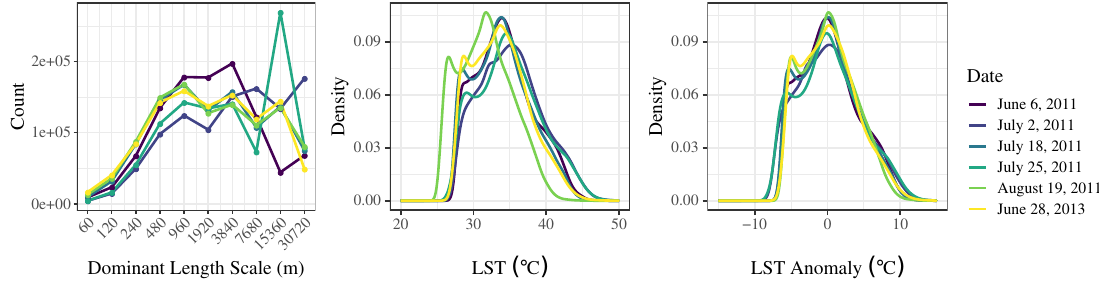
Figure 4. Distribution of dominant length scales ( left ), LST ( middle ), and LST anomalies ( right ) by date.